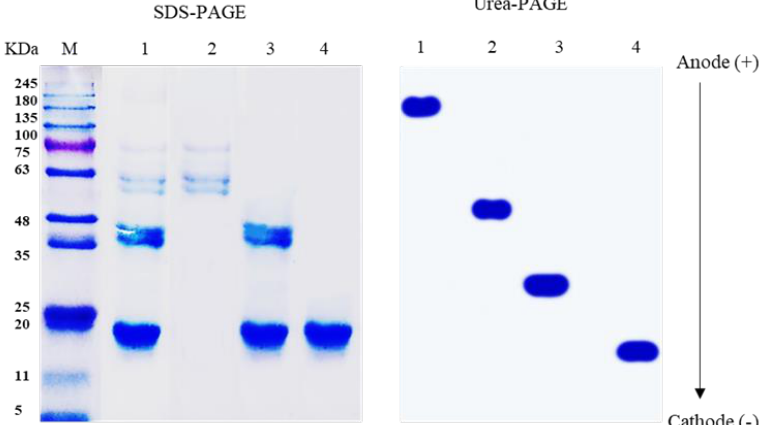
Figure 1. SDS-PAGE and Urea-PAGE of LPI (lane 1), 7S globulin (lane 2), 11S globulin (lane 3), and BS (lane 4) in comparison with protein marker (M).